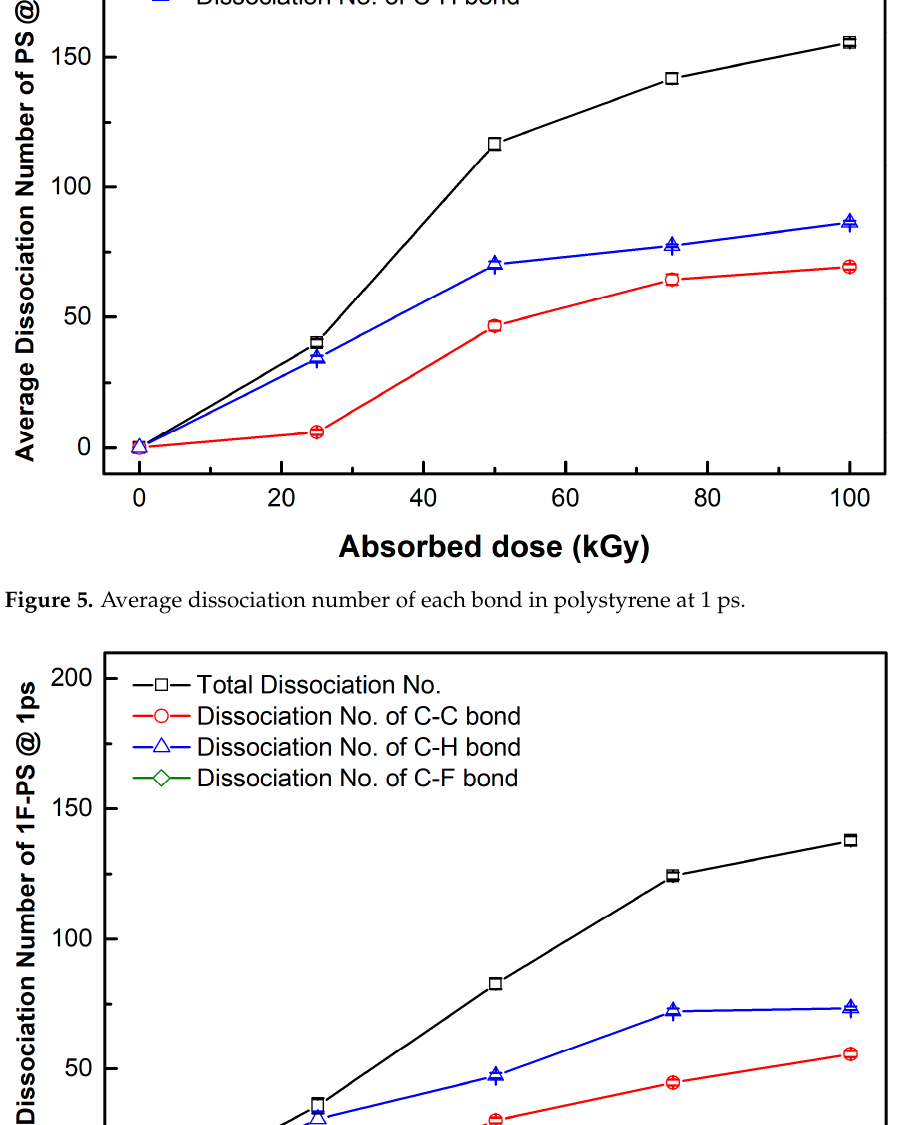
Figure 7. Average dissociation number of 5F-PS (poly(2,3,4,5,6-pentafluorostyrene)) at 1 ps.